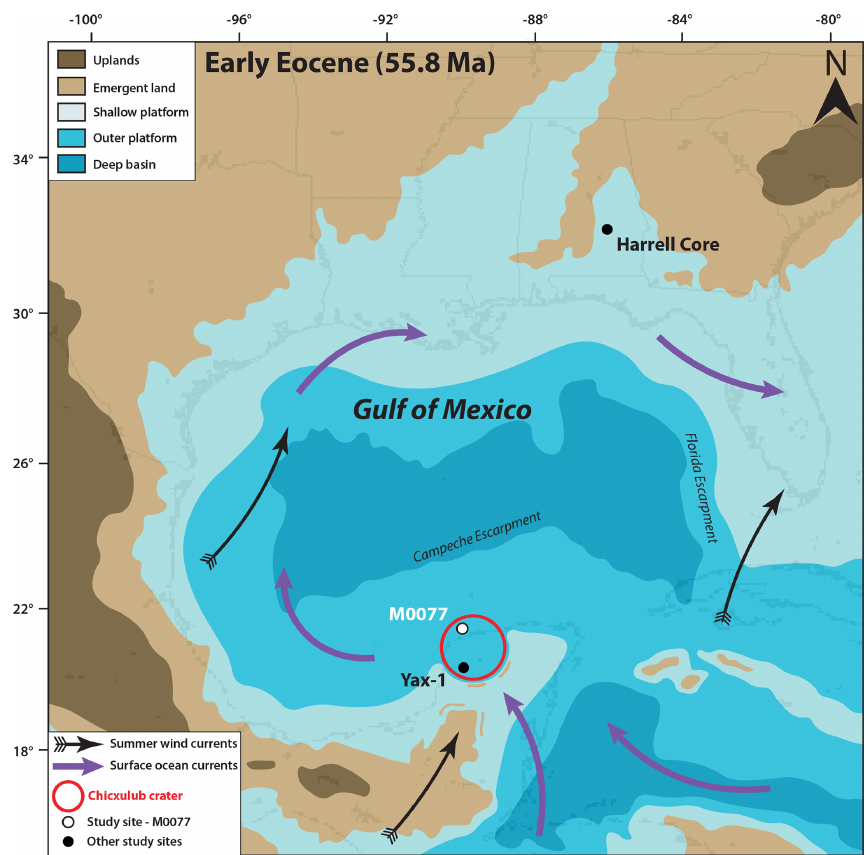
Figure 1. Paleocene–Eocene Thermal Maximum (55.8Ma) paleogeography of the Gulf of Mexico and surrounding regions (modified from Scotese and Wright, 2018), with locations of Site M0077 (IODP 364), Yax-1 (Whalen et al., 2013), and the Harrell Core in east–central Mississippi (Sluijs et al., 2014). The Harrell Core location has been adjusted to match the paleo-latitude and longitude at the PETM. Surface ocean currents and summer wind fields are from Winguth et al.